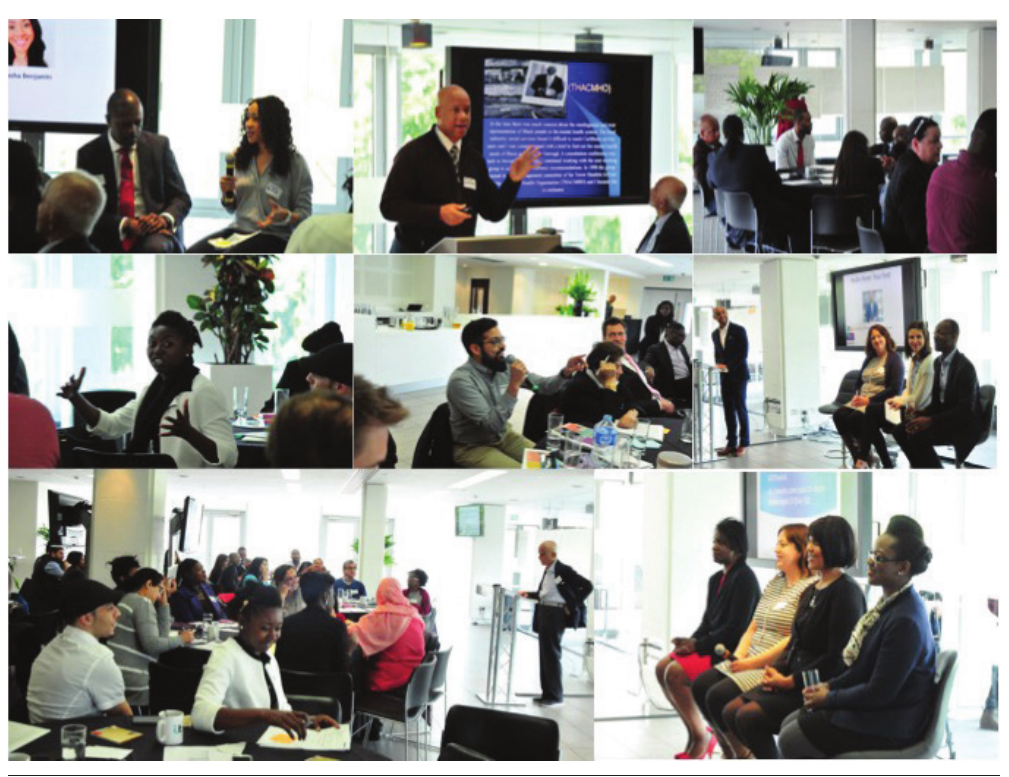
Figure 3: Photographic record of the